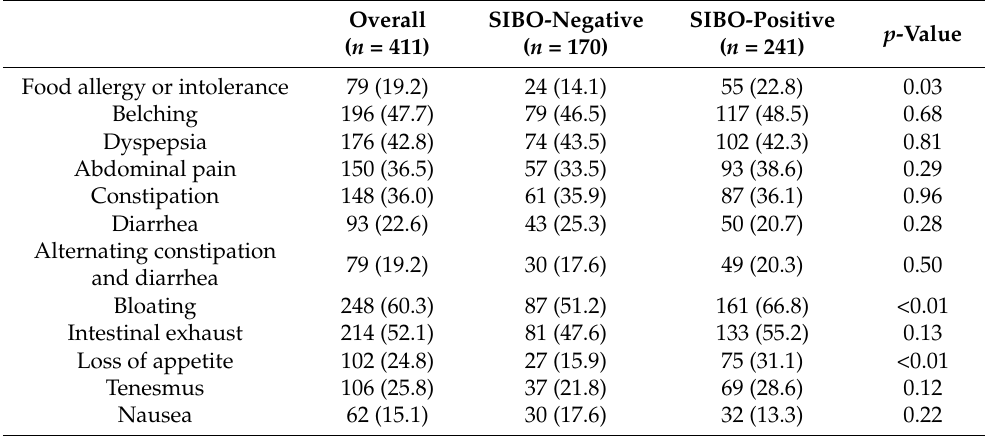
Table 2. Comparison of gastrointestinal symptoms between the SIBO-positive and SIBO-negative groups.